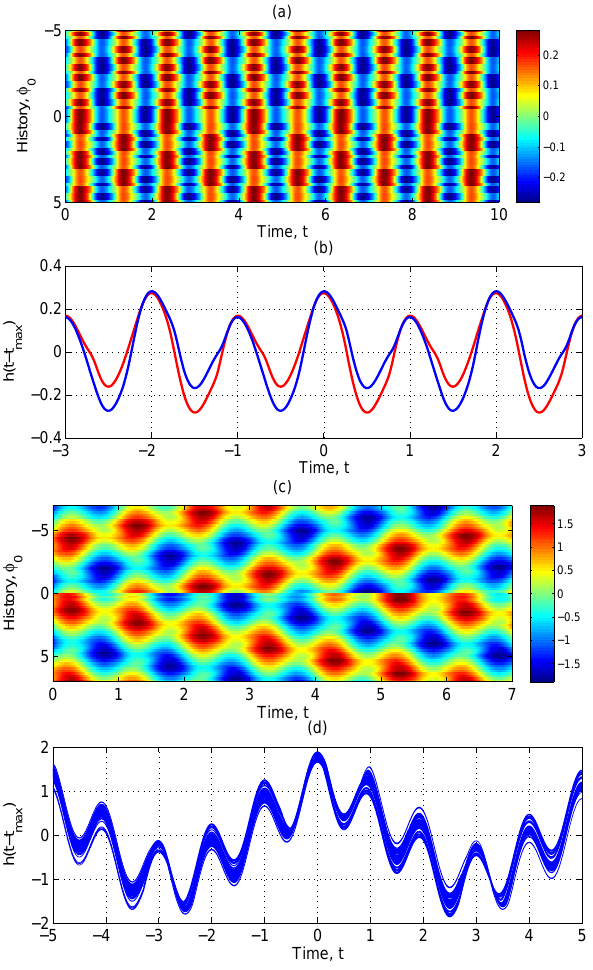
Fig. 10. Multiple stable solutions. Solution profile for (a, c) dif- ferent initial histories φ(t) ≡ φ 0 , and (b, d) the corresponding dis- tinct solutions. For visual convenience, the trajectories are shifted to have their global maxima at t = 0. Panels (a, b): model be- haviour at point C = (τ = 0 . 5 ,κ = 11 ,b = 1 . 7842 ) , where there exist 2 distinct solutions; and panels (c, d): model behaviour at point D = (τ = 1 . 4579 ,κ = 11 ,b = 4 ) , where there exist 61 distinct solu- tions.